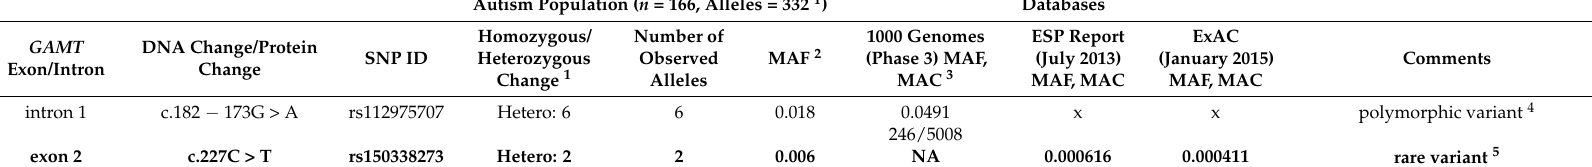
Table 2. Summary of guanidinoacetate methyltransferase ( GAMT ) gene sequencing results. Variants identified in the ASD population are noted, and minor allele frequency (MAF) calculated. MAF of variants present in 1000 Genomes, ESP and Exome Aggregation Consortium (ExAC) databases are shown for comparison. 1 Total number of samples = 166 (332 alleles); 2 MAF = minor allele frequency; the number of alleles in which variant was found/total number of alleles; 3 MAC = minor allele count; the number of times the minor allele was observed in the sample population of chromosomes; 4 Polymorphic variant: (>0.01 MAF in one database); 5 Rare variant: ≤ 0.01 MAF in at least one published database; coding sequence (exons) are in bold; and dbSNP: Single Nucleotide Polymorphism